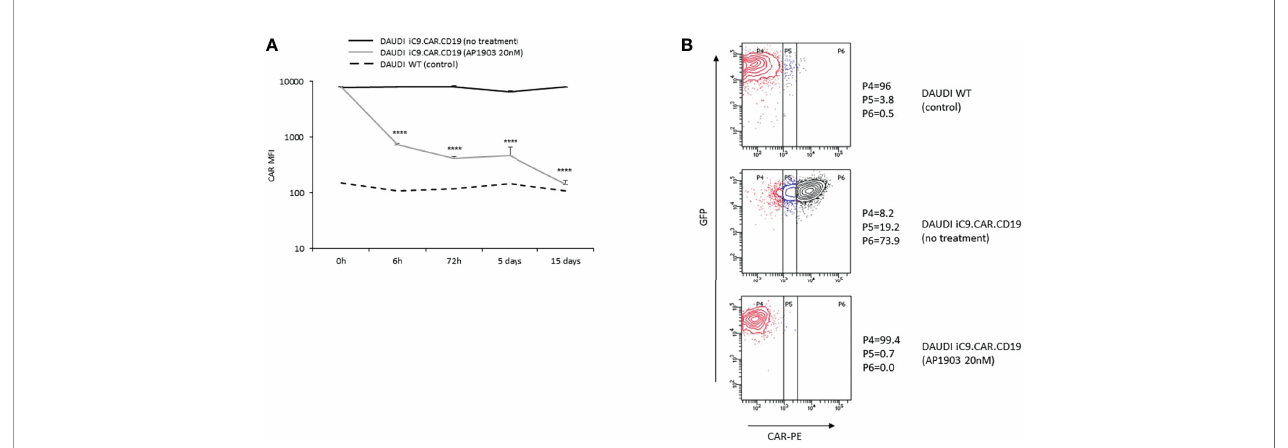
FIGURE 3 | iC9 activation controls CAR+ B-cells with dim expression of transgene. (A) iC9.CAR.CD19 DAUDI cell line were treated with 0 nM (black line) and 20 nM of AP1903 (gray line); CAR MFI was monitored over time by fl ow cytometry analysis from day 0 to day 15 after treatment and compared to the control WT DAUDI cell line. (B) CAR expression detected by fl ow cytometry in the DAUDI WT cell line (negative control; top panel), iC9.CAR.CD19 DAUDI cell line (no treatment, middle panel), or iC9.CAR.CD19 DAUDI cell line treated with 20 nM of AP1903 (day +15; bottom panel) ****p-value ≤ 0.00001.